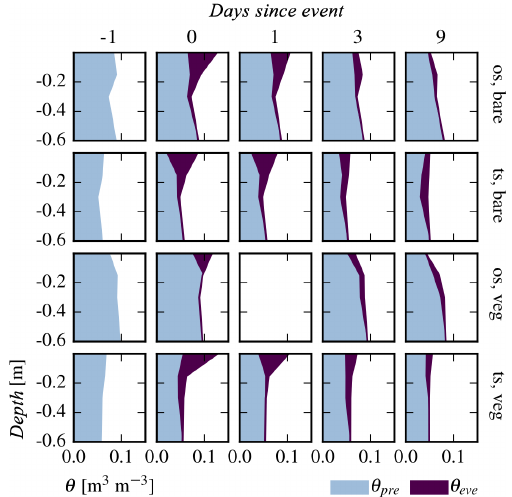
into pre-event soil water content θ pre and infiltrated event soil water content θ eve . Observations are displayed for plots under bare soil (bare) or vegetation cover (veg) at open sites between tree crowns (os) and shaded sites beneath tree crowns (ts). Numbers at the top mark days since the watering event. Uncertainties for soil moisture observations during the experiment amount on average to 2.3%vol. 1 on open, vegetated plots needed to be omitted due to inadequate field data